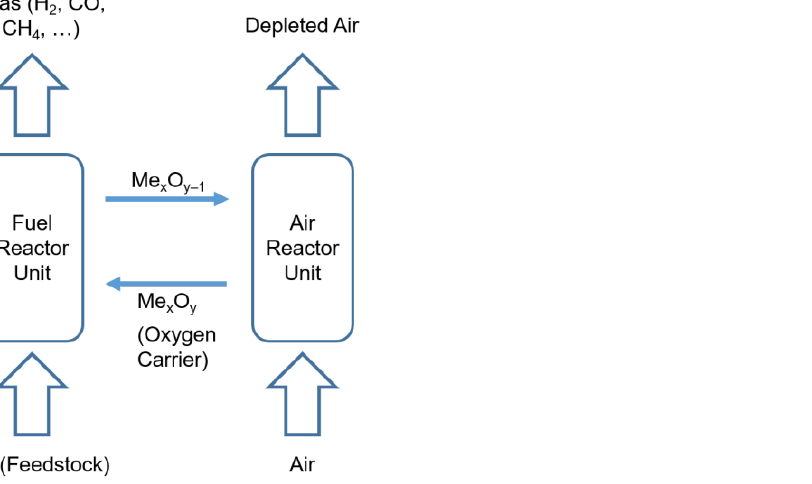
Figure 1. Schematic sketch of the chemical looping gasification process, modified after [8]. The reduced metal oxide Me x O y − 1 is circulated to the air reactor to be re-oxidized (Me x O y ) before a new cycle starts.